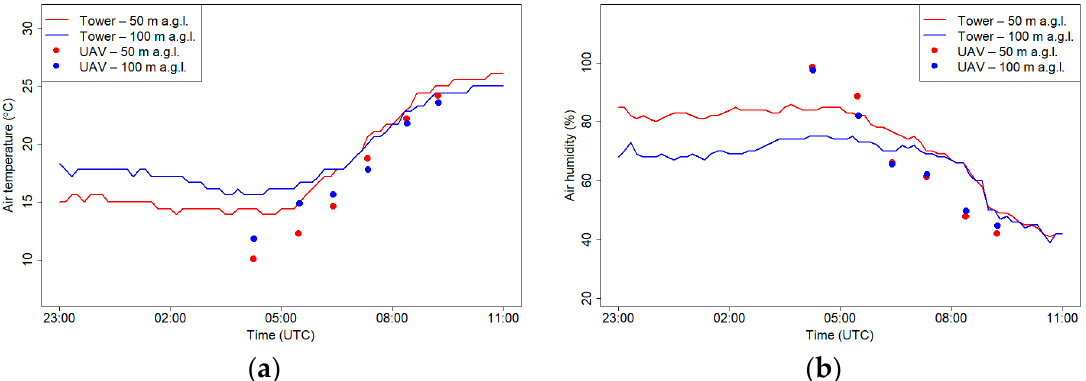
Figure 14. Air temperature ( a ) and relative humidity ( b ) at 50 and 100 m a.g.l. measured at the RTCN tower and by UAV on 21 September 2018.